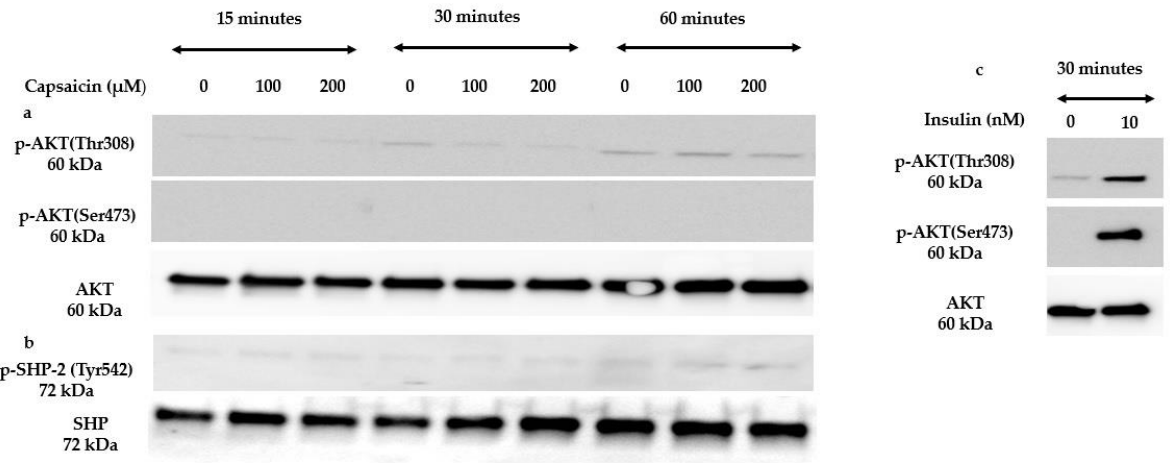
Figure 5. Western blot results of insulin signalling molecules in the presence of capsaicin over 60 min. ( a , b ) Representative Western blots for the AKT and SHP-2 phosphorylation in mouse differentiated C2C12 cells treated with 100 and 200 µM capsaicin over 60 min. ( c ) Immunoblots of p-AKT and AKT protein expression in the 10 nM insulin-treated myotubes after 30 min.